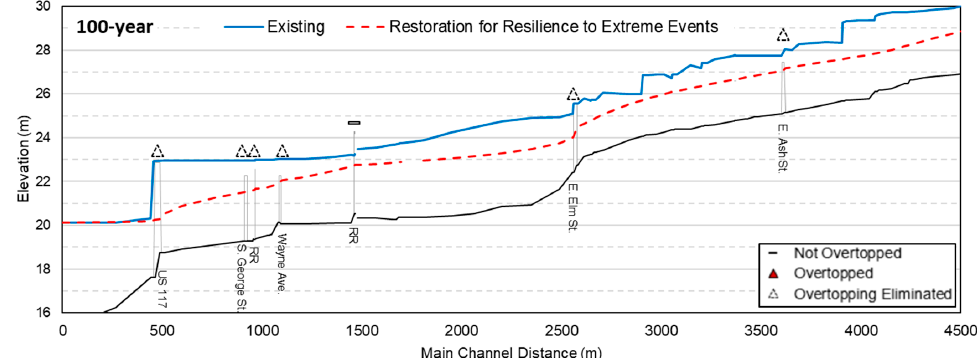
Figure 10. Water surface profiles for the Existing Condition and the Restoration for Resilience to Extreme Events scenario for the 100-year event.